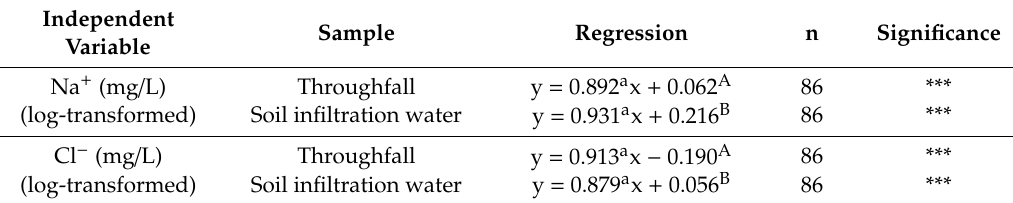
Table 1. Linear regression of electric conductivity (EC (mS / m); dependent variable: y; log transformed) and Na + and Cl - concentrations of throughfall or soil-infiltration water (independent variable: x ). Data on 24 September 2010 were